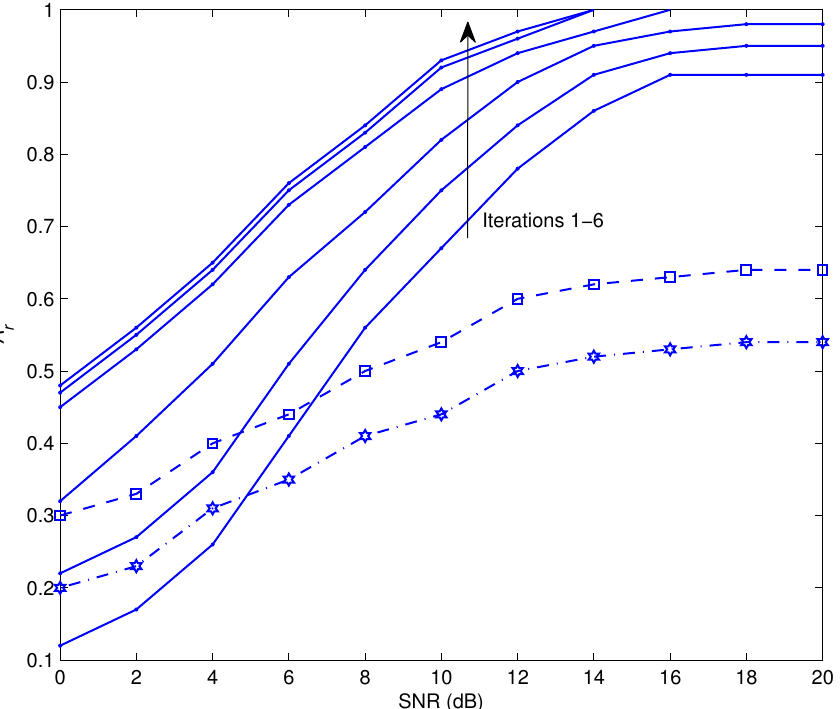
Figure 2. A r as a functions of SNR at different iterations. The proposed algorithm is illustrated by the solid lines, the algorithm of [40] is displayed by the dashed lines, and the algorithm of [41] is indicated by the dot-dashed